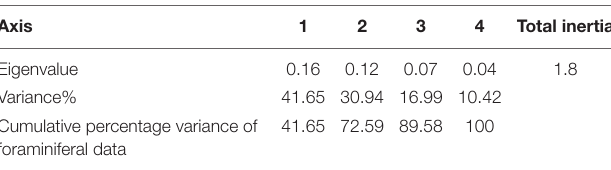
TABLE 6 | Eigenvalues and cumulative percentage of variances of foraminiferal and environmental data obtained by the canonical correspondence analysis (CCA).